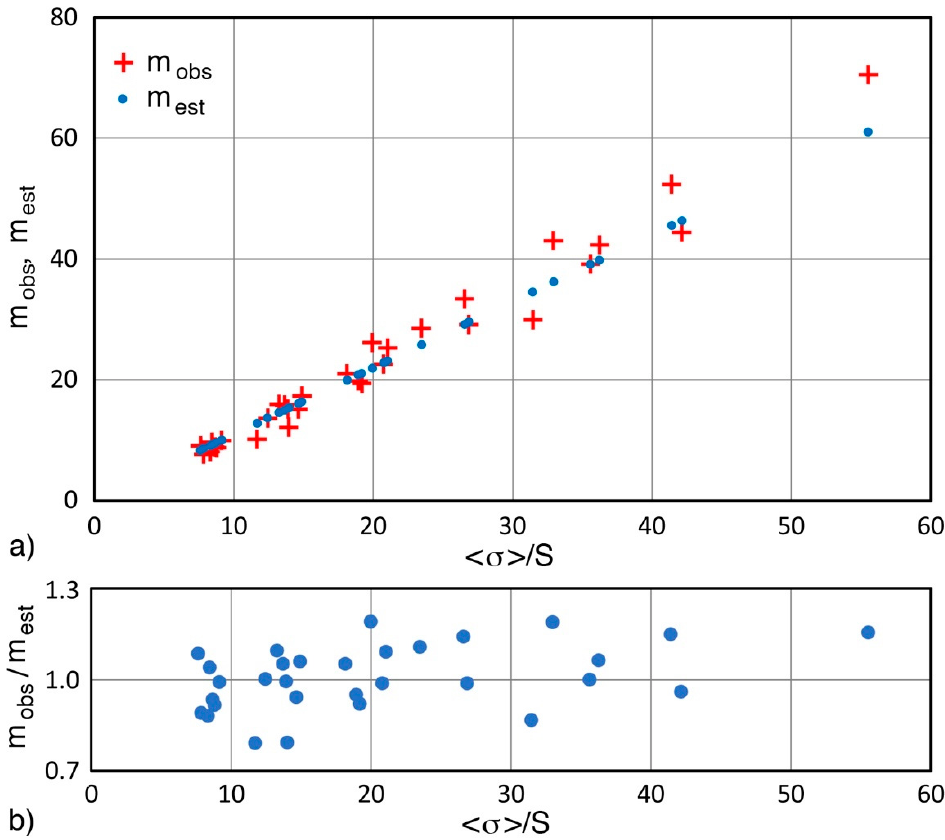
Figure 3. Plot of m obs /m est (blue dot) vs. < σ >/S for the whole datasets.